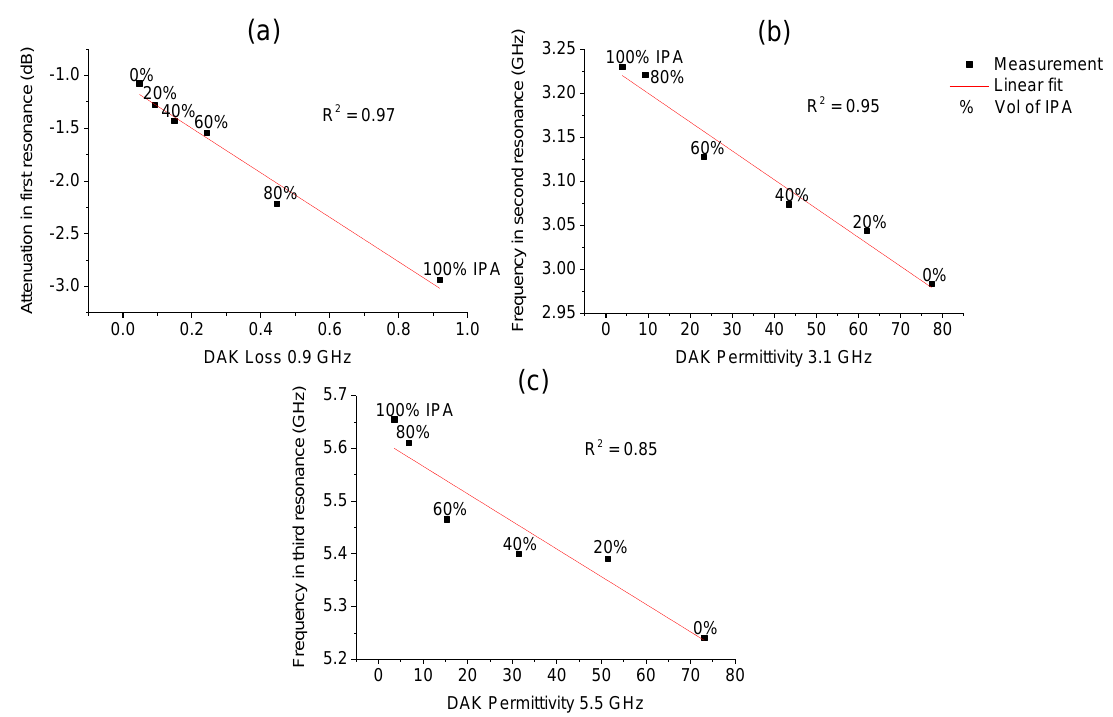
Figure 14. Isopropanol measurements versus DAK measurements: ( a ) first resonance vs. loss tangent; ( b ) second resonance vs. relative permittivity; ( c ) third resonance vs. relative permittivity. With saline samples, a low frequency shows usable results as the attenuation increased as the saline concentration increased. Figure 15 shows the measurement data.